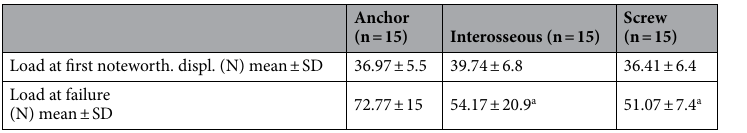
Table 1. Tension force values of the repair techniques. a Statistically significant difference compared to the “anchor” repair technique.